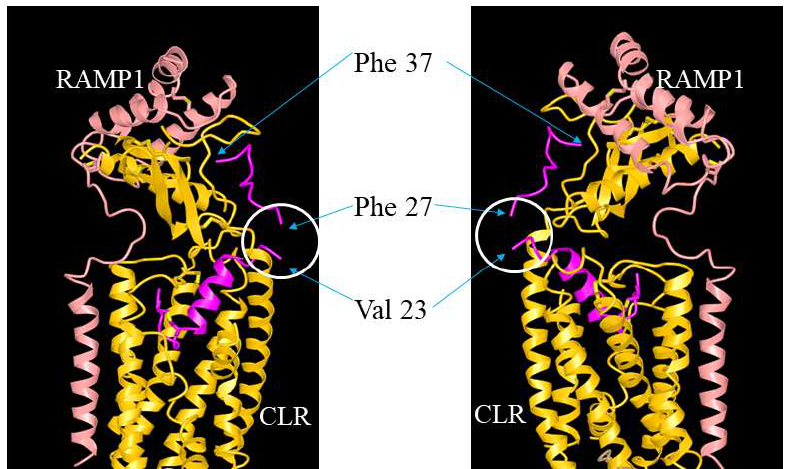
Figure 9. Illustration of the putative position of the hinge region in CGRP/ADM family peptides and analogs. The interaction of ADM analogs and CLR/RAMP receptors could be analogous to that between CGRP and CLR/RAMP1 (RCSB protein data bank [PDB] structure 6E3Y). The structure view of CGRP-CLR/RAMP1 complex 6E3Y is depicted from two different angles, and it includes CGRP (red), RAMP1 (pink), and CLR (yellow) components. The unresolved structure at the hinge region is indicated by a white circle. Residues Val23 and Phe27, which are neighboring residues of the hinge region (Lys24-Asn26), and the C-terminal Phe37 of CGRP are indicated by arrows. Lipidation has been used to improve the pharmacokinetics of peptides such as glu- cagon-like peptide-1 (GLP-1) and glucagon analogs by enabling them to be bound by al- bumin and other serum proteins, therefore reducing elimination by kidneys and degra- dation by serum proteases [62]. Earlier studies have shown that lipidated CGRP, CGRP antagonist, and ADM have protracted pharmacokinetic properties [63–65]. Unlike earlier studies, we showed that palmitoylation significantly enhances the receptor-activation ac- tivities of select ADM and chimeric analogs. Although it is not clear how palmitoylation modification enhances the bioactivity of these analogs, earlier studies of benzoylated and lipidated analogs of CGRP antagonist CGRP8-37 have shown that lipidation may facilitate the association of peptides with the cell membrane and increase the local concentration of peptides within the vicinity of the receptor [65–67]. Because a key ligand-binding site in CLR/RAMP receptors is a hydrophobic patch extending from the base of CLR loop 4 to loop 3 [55,66], the palmitoylated analogs may have better interactions with the hydropho- bic binding motifs, therefore gaining the enhanced bioactivity. In addition, palmitoylation may provide a better mimic of the membrane environment that a ligand normally encoun- ters when it interacts with a cell surface receptor, therefore improving the conformational dynamics of ligand-receptor interactions [68–71]. However, an improper combination of ADM/ADM2 sequence in a chimeric analog may drastically disrupt the ligand-receptor interaction even though a facilitating palmitoyl moiety is present. ADM and ADM2 have organ-protective effects in animals with heart failure, myo- cardial infarction, stroke, resistant hypertension, pulmonary arterial hypertension, preeclampsia, secondary lymphedema, or diabetic ulcer [19,72–95]. These peptides may prevent organ injuries by improving endothelial cell functions and vascular barrier integ- rity and reducing oxidative stress as well as by improving cardiac output and renal